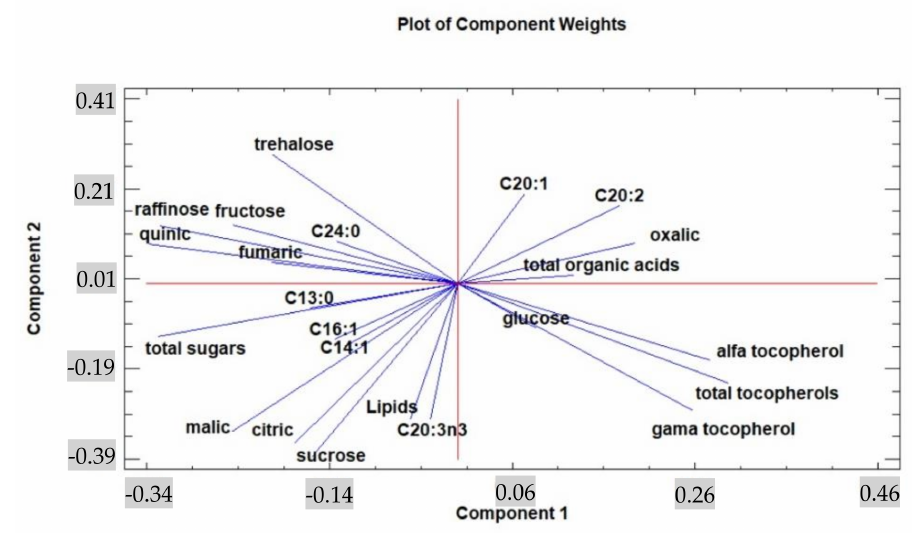
Figure 3. The loading plot of principal components 1 and 2 for the tested variables at different maturation stages of cardoon